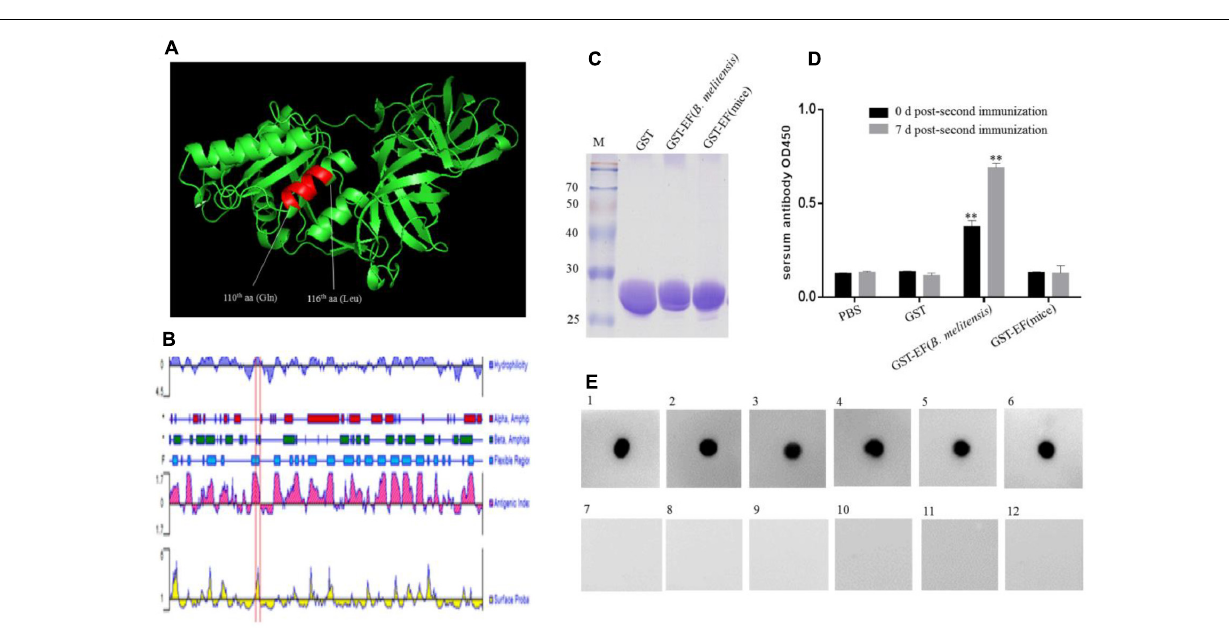
FIGURE 5 | Identification of the immunogenicity of epitope EF. (A) Localization of the identified BD 6 epitope in a partially predicted 3-D structure of B. melitensis EF-Tu protein is highlighted in an α -helix. (B) The antigenic index of EF-Tu protein was predicted by DNAstart and the epitope 110 QTREHIL 116 was located on a highlighted antigenic index region (red box). (C) SDS–PAGE analysis of purified GST, GST-EF ( B. melitensis ), GST-EF (mice) protein. (D) The level of serum antibody IgG immunized with GST-EF ( B. melitensis ), GST-EF (mice) protein was detected by ELISA on 0 day and 7 days post-second immunization. ∗∗ p < 0.001 represents the significant difference compared with PBS group. (E) Dot-blot analysis of B. melitensis -infected mouse sera with synthetic epitope EF peptide as antigen. 1–5, B. melitensis -infected sera; 7–11, no- B. melitensis -infected sera; 6, BD 6 McAb as positive control; 12, Membrane incubated without primary antibody as